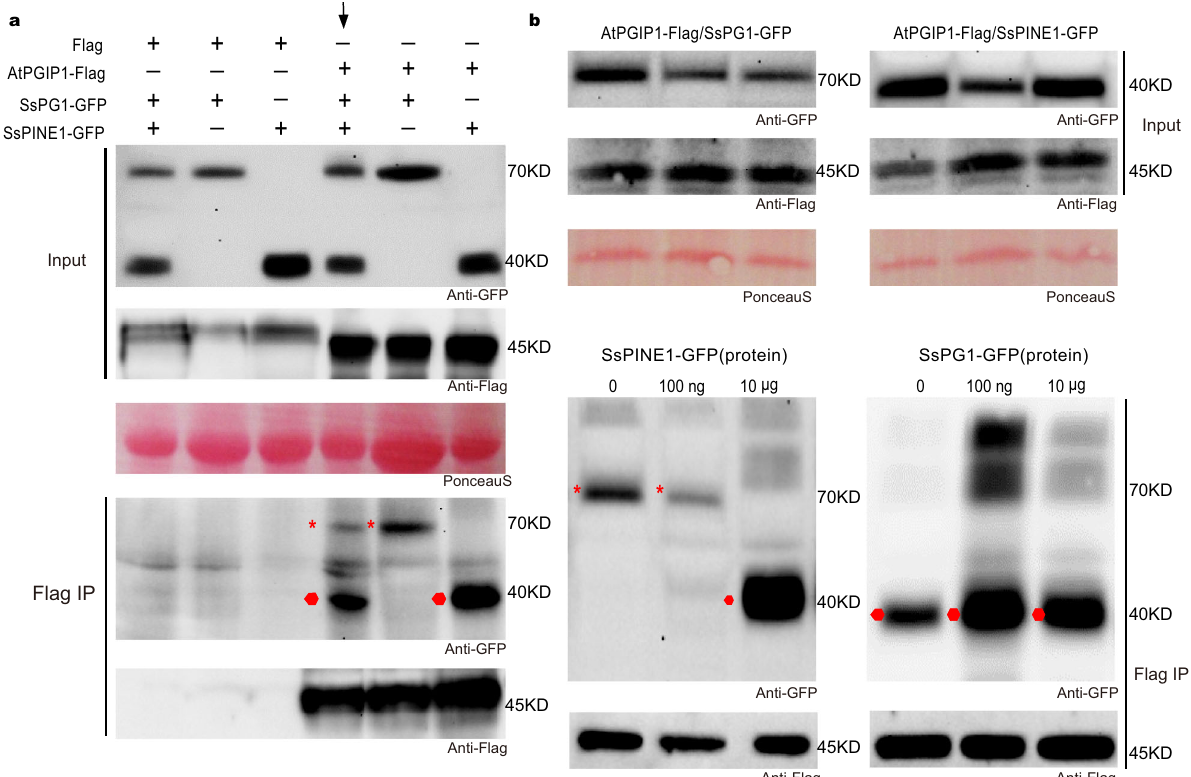
Fig. 3 SsPINE1 outcompetes SsPG1 in binding with AtPGIP1. a More SsPINE1 co-precipitated with AtPGIP1 than SsPG1 in co-IP assay. When both SsPINE1-GFP and SsPG1-GFP were together co-in fi ltrated with AtPGIP-3XFlag, SsPINE1-GFP co-precipitated more effectively with AtPGIP1-3xFlag than SsPG1-GFP (indicated by the arrow). b SsPINE1 enhances the dissociation of SsPG1 from AtPGIP1 (left panel). In contrast, SsPG1 cannot compete effectively with SsPINE1 for AtPGIP1 binding (right panel). N. benthamiana leaves were agroin fi ltrated with SsPG1-GFP and AtPGIP1-3xFlag . 0, 100 ng and 100 μ g of puri fi ed SsPINE1-GFP fusion protein from yeast culture was mixed with equal volumes of the same leaf lysate, immunoprecipitated with anti-Flag agarose (Flag IP), and analyzed by Western blot using anti-GFP antibody. Similarly, puri fi ed 0, 100 ng and 100 μ g of SsPG1-GFP fusion protein from yeast culture were mixed with equal volumes of the same leaf lysate of N. benthamiana leaves agroin fi ltrated with SsPINE1-GFP and AtPGIP1-3xFlag . Red asterisks and round dots indicate the expected sizes of SsPG1-GFP and SsPINE1-GFP, respectively. Representative results are shown, and each experiment was performed three times with similar results obtained. Source data are provided as a Source data fi with AtPGIP1 (Fig. 3b, right panel). The results showed that SsPG1 cannot replace SsPINE1 in the SsPINE1/AtPGIP1